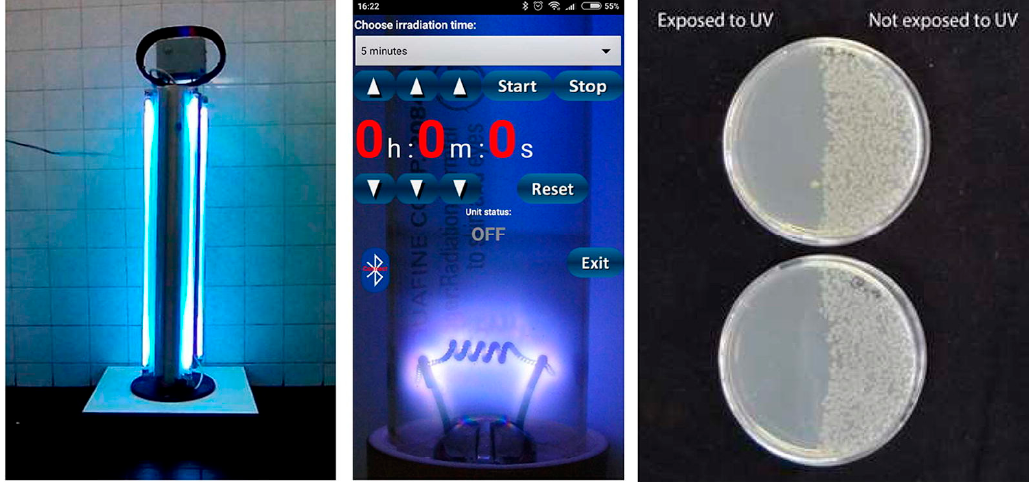
Figure 3. An open source programmable and low-cost ultraviolet room disinfection device ( left ), controls ( middle ), and results ( right ).